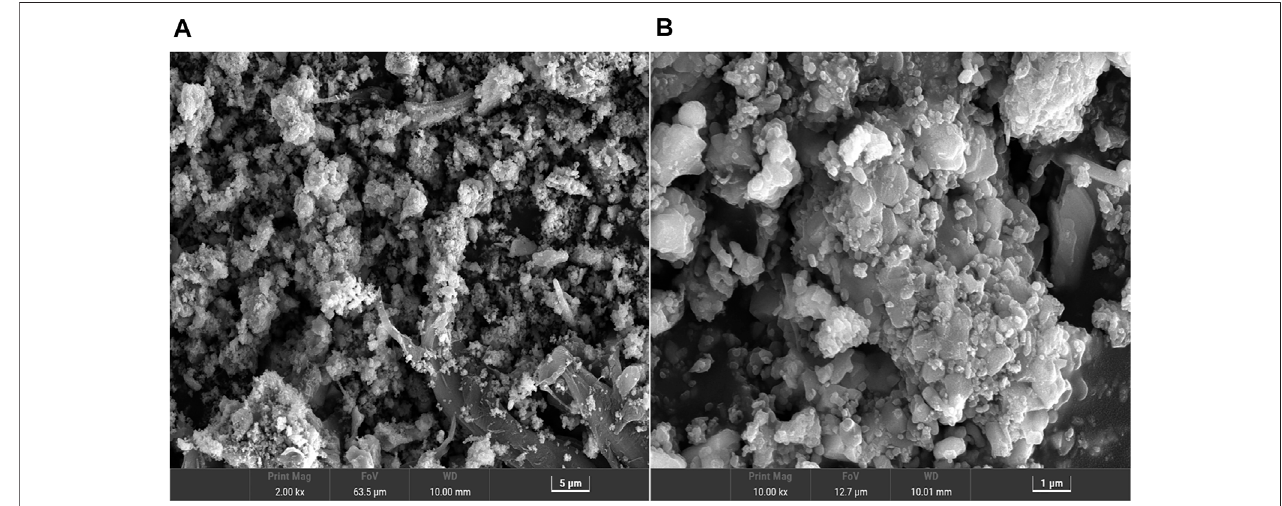
FIGURE 5 | SEM of catalyst b: (A) magni fi ed 2000 times (B) magni fi ed 10,000 times.